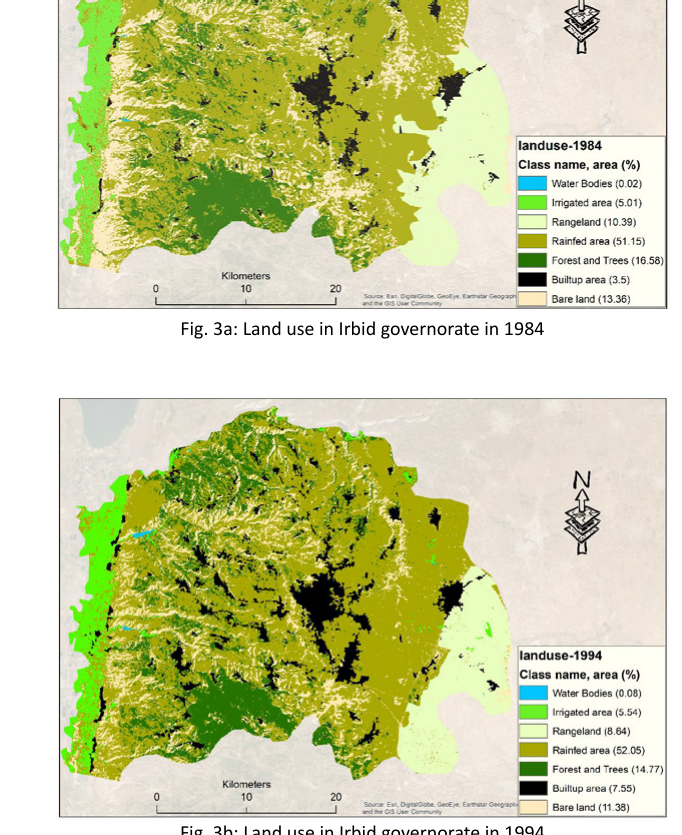
Fig. 3b: Land use in Irbid governorate in 1994